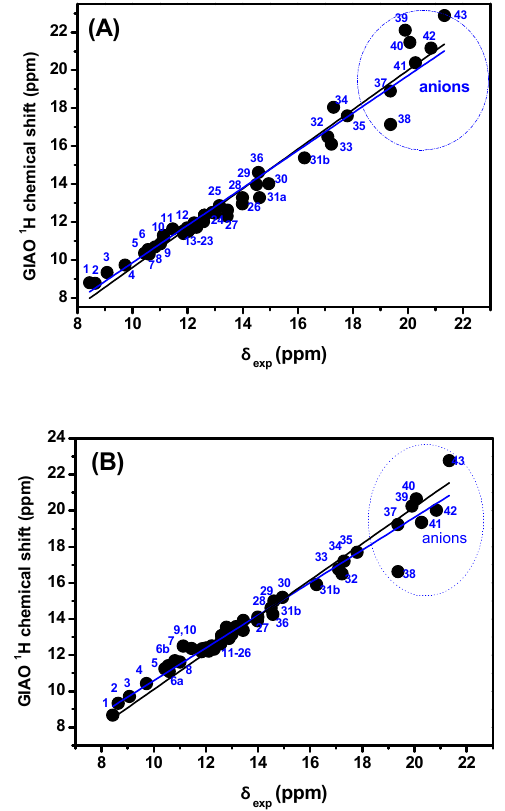
Figure 11. Calculated (at the GIAO/B3LYP/6-311G+(2d,p) level of theory with CPCM in CHCl 3 ) vs. experimental chemical shifts of the OH protons of the compounds 1–43 of Figure 9 with minimization of the structures at the M06-2X/6-31+G(d) ( A ) and B3LYP/6-31+G(d) ( B ) level of theory, respectively. The blue line corresponds to the linear fit and the black line to the linear fit through the zero. Reprinted, with permission, from [47]. Copyright 2015, The Royal Society of Chemistry.